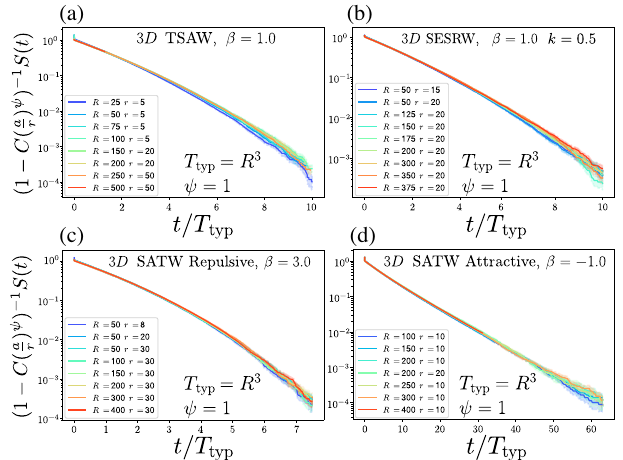
FIG. 6. Asymptotic FPT distribution of noncompact self- interacting random walks in confined domains for fresh initial conditions. Here, S ð t Þ is the survival probability of the random walker, whose scaling with geometrical parameters is deduced from Eq. (28). The collapse of numerical simulations after rescaling for different values of the geometrical parameters captures the dependence of the FPT distribution on r , R . Simulations are performed in 3 d boxes of size R with reflecting boundary conditions, and the constant C is measured numerically (here, a is a cube of size 1). (a) 3 d TSAW with β ¼ 1 . 0 . (b) 3 d SESRW with β ¼ 1 . 0 and k ¼ 0 . 5 . The 3 d SATW repulsive with β ¼ 3 . 0 (c) and with β ¼ − 1 . 0